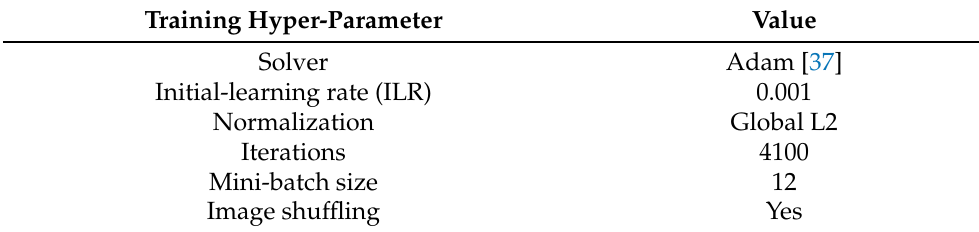
Table 2. Summary of training